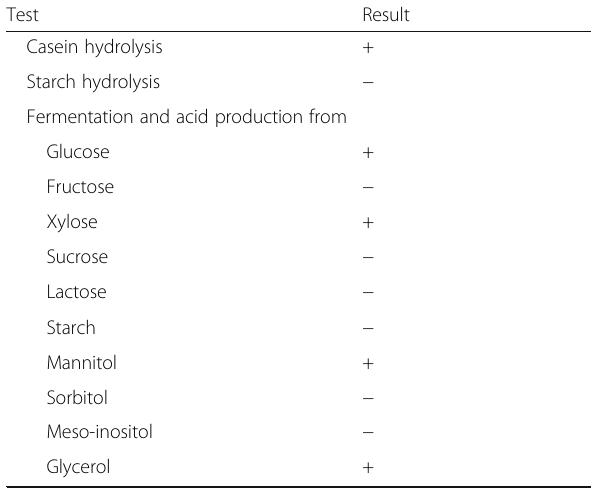
Table 2 Morphological, physiological, and biochemical characteristics of isolate BA5 (Continued)